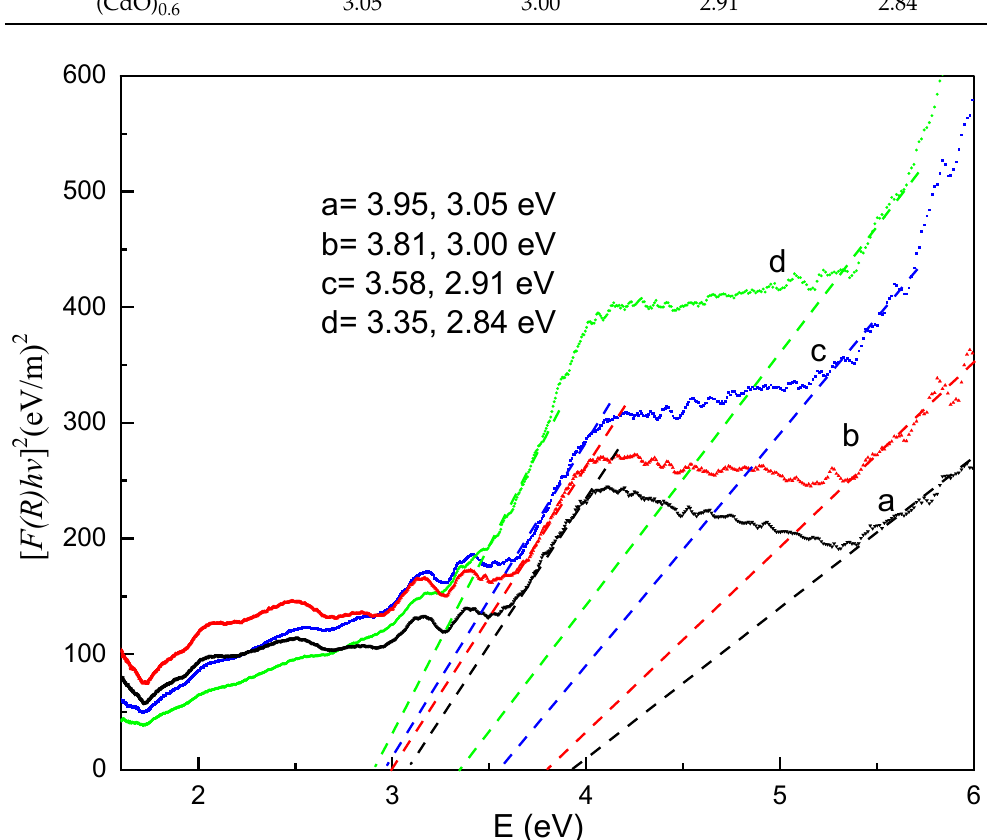
Figure 8. The bandgaps values of prepared samples at temperatures of (a) 500, (b) 600, (c) 700, and (d) 800 °C.